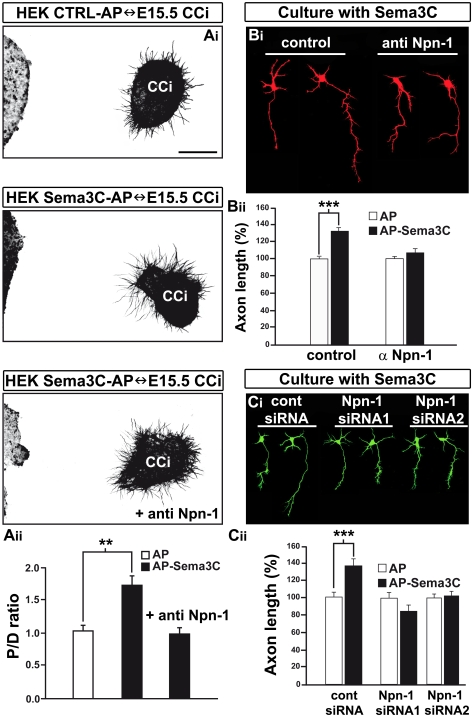
Sema3C acts through Npn-1 to attract and promote growth of cortical axons.(A–C) Typical patterns of axonal outgrowth (Ai) from explants of E15.5 CCi cocultured with AP-control and AP-Sema3C–expressing HEK293T cells in the presence or absence of 20 µg/ml polyclonal anti–Npn-1 antibodies. (Aii) Quantification of the axonal guidance responses to AP-control and AP-Sema3C–expressing HEK293T cells. Data are expressed as a P/D ratio, where P and D are the mean lengths of axons in the quadrants proximal and distal to the cell aggregate [77]. In control conditions, a P/D ratio close to 1 (P/D ratio = 1.04±0.09) indicates radial outgrowth. AP-Sema3C causes strong chemoattraction of cortical axons (P/D ratio = 1.73±0.15). This effect is blocked by anti–Npn-1 antibodies (P/D ratio = 0.99±0.09). (Bi) Typical images of dissociated neurons from E15.5 CCi cultured in the presence or absence of 10 µg/ml polyclonal anti–Npn-1, and of 10 nM AP-Sema3C. (Bii) Histograms of Sema3C effects on the growth of dissociated neurons from CCi. Data are presented as mean axonal length ±SEM and are normalized to 100% with respect to values obtained in control conditions. The anti–Npn-1 antibodies prevent stimulation of axon growth by Sema3C. (Ci) Dissociated neurons of CCi electroporated with GFP-expressing vector together with either control siRNA or Npn-1 siRNAs 1 and 2 (see Materials and Methods) were cultured in the presence or absence of 10 nM AP-Sema3C. (Cii) Quantification of the effects of Npn-1 siRNAs on axon length. Knock-down of Npn-1 completely abolishes the growth-promoting effect of Sema3C. Data are mean axonal lengths ±SEM calculated as a percentage of mean values obtained in control conditions for each experiment. Double asterisks (**) indicate significantly different with p<0.01; triple asterisks (***) indicate significantly different with p<0.001.